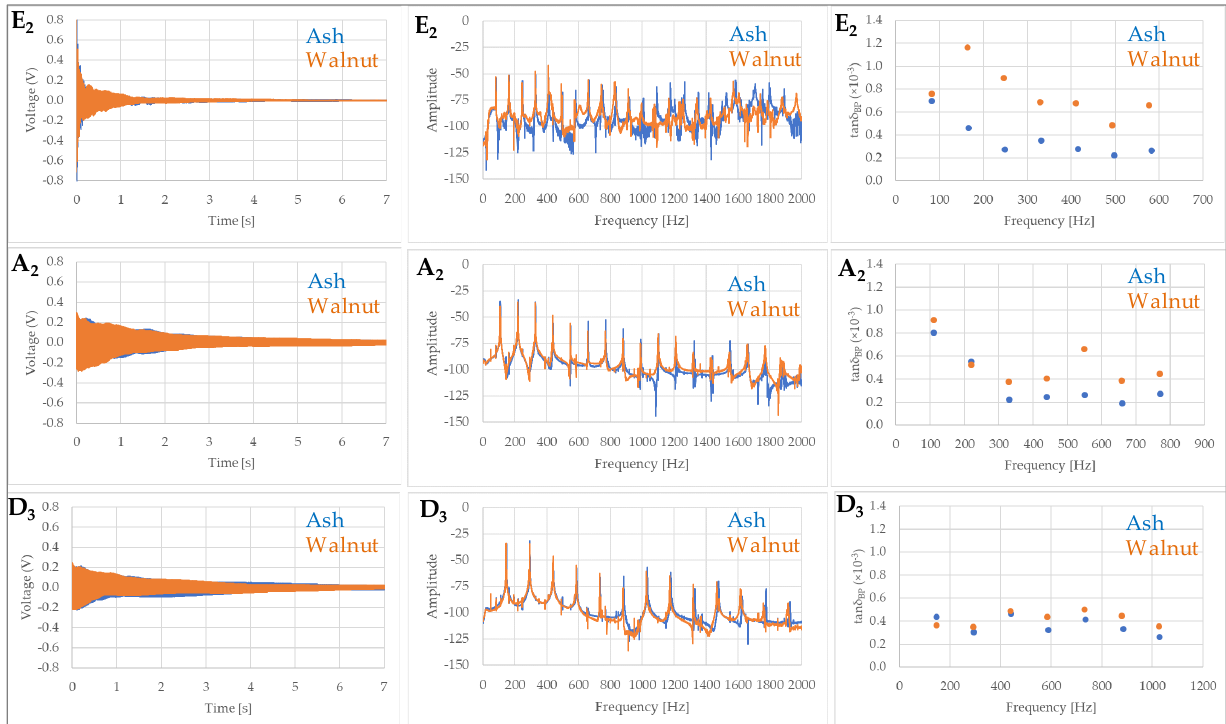
Figure 6. Measured wavelet–time signal, FFT frequency spectra and damping coefficient in the first 7 vibration modes of the open strings (E 2 —top; A 2 —middle, D 3 —bottom) of an electric guitar with body made of ash wood ( ― ) and walnut wood ( ― ).